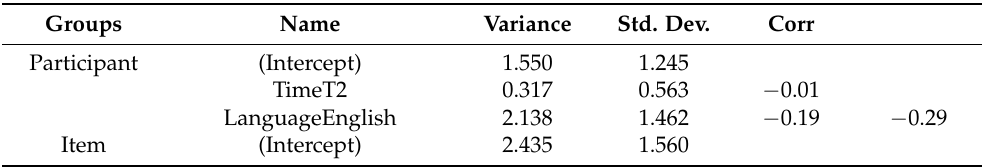
Table A7. Random effects of the logistic mixed-effects regression comparing performance in English and Arabic at T1 and T2 for the two AOA